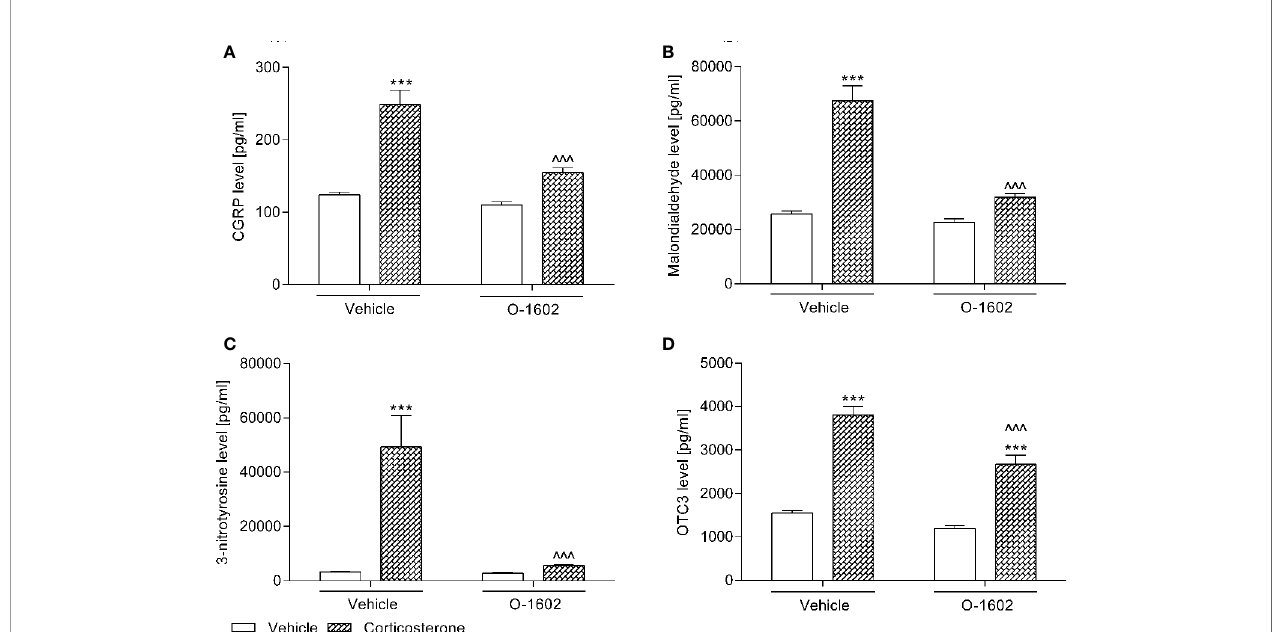
FIGURE 2 | In fl uence of the 7-day intravenous administration of O-1602 (0.25 mg/kg/day) on the levels of (A) calcitonin gene related peptide (CGRP), (B) malondialdehyde, (C) 3-nitrotyrosine, and (D) organic cation transporter 3 (OCT3) in the the bladder urothelium of rats subjected to the 14-day corticosterone treatment (20 mg/kg/day, subcutaneously). The values represent the mean+SEM (n=15 animals per group). ***p<0.001 versus vehicle-treated group, ^^^p<0.001 versus corticosterone-treated group (Bonferroni ’ s post hoc